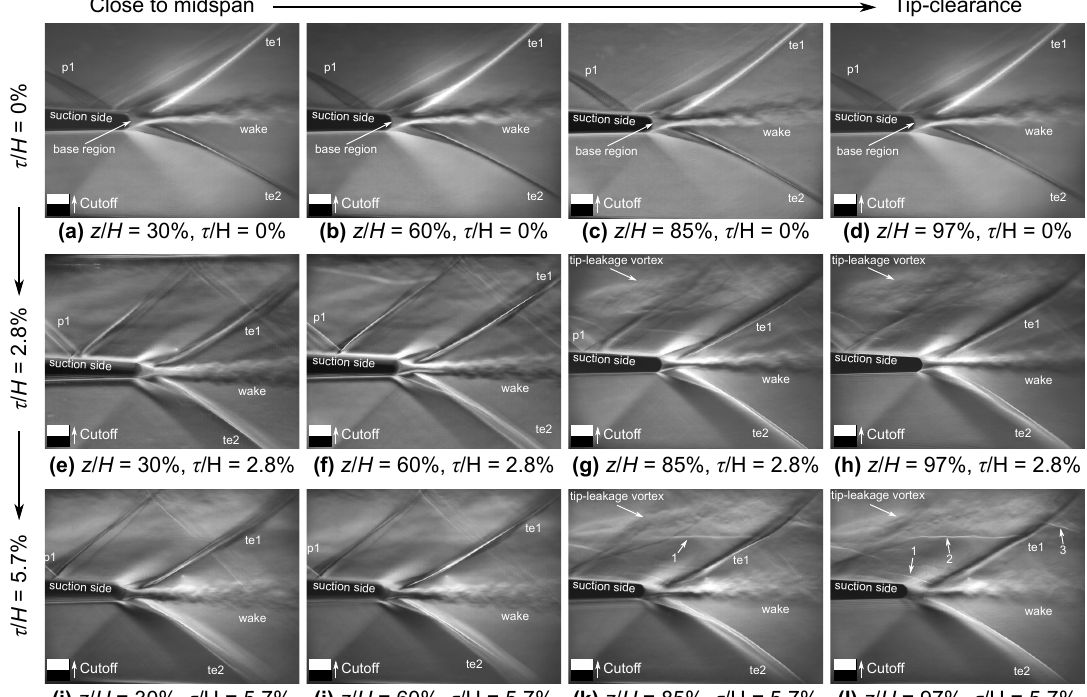
Figure 9. Focusing schlieren images of the flow field in four different planes of focus. The rear third of the blade chord length and trailing edge region is shown for three tip-clearance heights of τ / H = 0%, images ( a – d ); τ / H = 2.8%, images ( e – h ); τ / H = 5.8%, images ( i – l